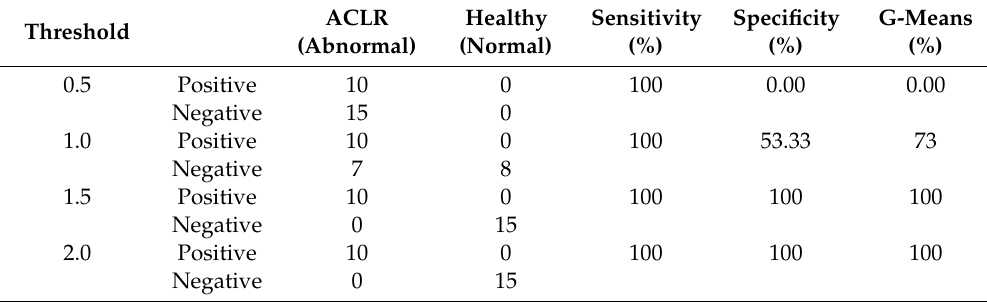
Table 8. Sensitivity analysis of the threshold.